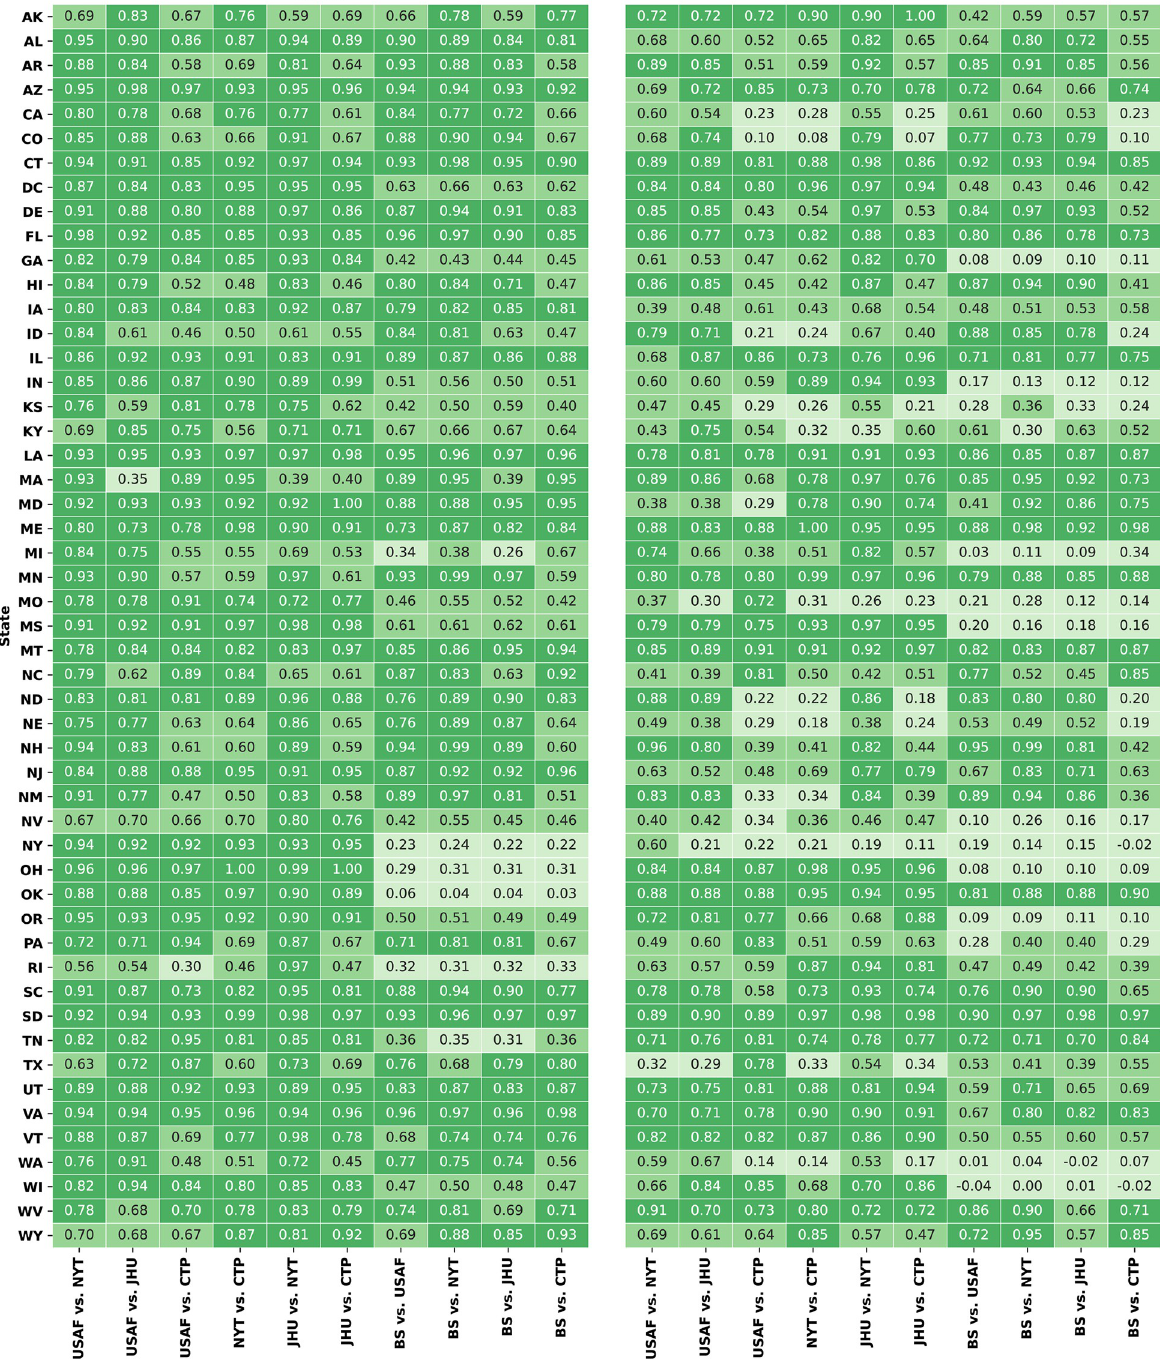
PLOS ONE | https://doi.org/10.1371/journal.pone.0251470 November3, 2022 8 /